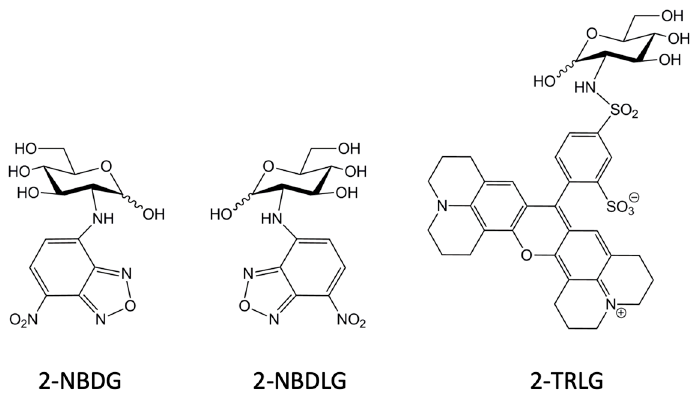
Figure 2. Structures of NBD-conjugated green fluorescence-emitting d -glucose tracer 2-NBDG, NBD-conjugated l -glucose tracer 2-NBDLG (the mirror image isomer of 2-NBDG), and Texas Red-conjugated, red fluorescence-emitting, membrane-impermeable l -glucose analogue 2-TRLG. After incubation with 2-NBDG for 10 minutes, living Escherichia coli ( E. coli ) cells emitted green fluorescence with varying intensities (Figure 3A–C), whereas no fluorescence was detected in ethanol-treated dead cells (not shown)